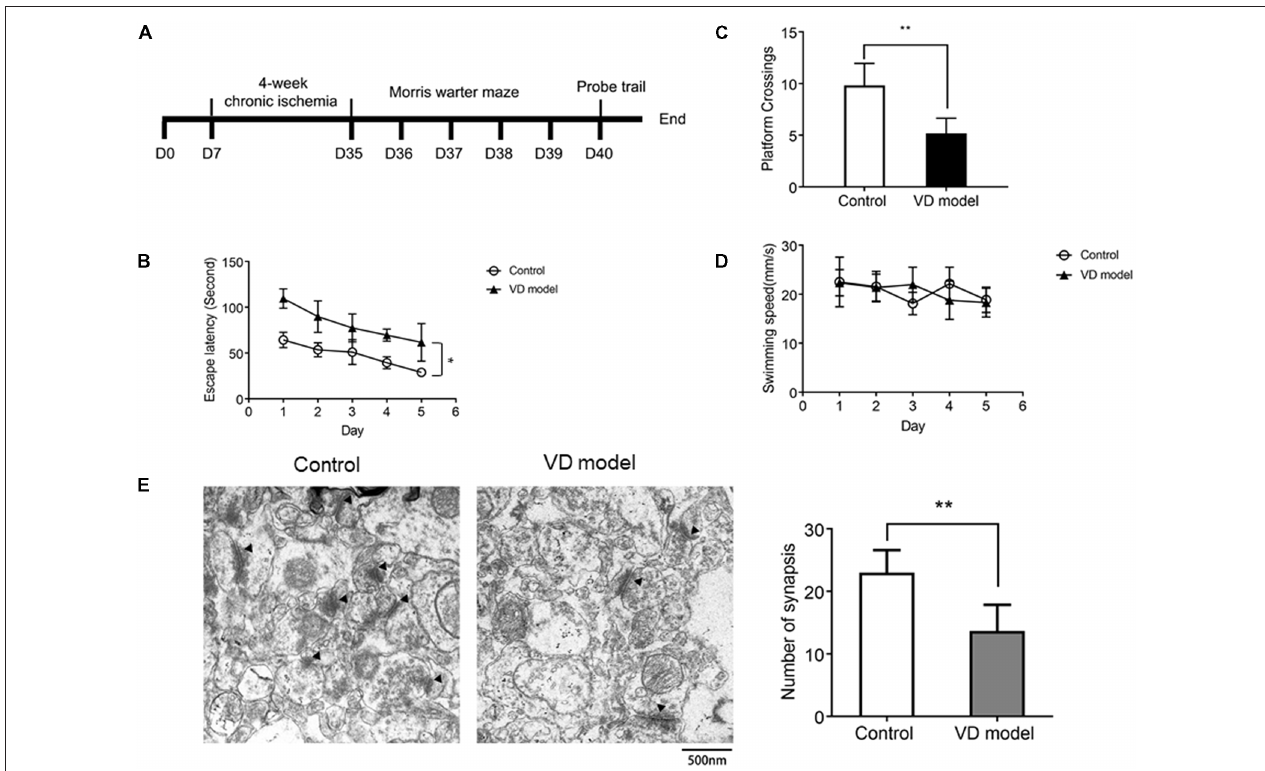
FIGURE 1 | Chronic ischemic rat model exhibits the decline of spatial learning capability ( n = 13/group) and synapse loss in the hippocampus relative to control group ( n = 6/group). (A) The timeline of animal experiment. (B) The escape latency of individual rats was processed by a Morris water maze that lasts for 5 days (four times per day). (C) The number of platform crossings measured within 120 s. (D) The motor function was assessed by the swimming speed. (E) Synapses were indicated with black triangles; bar chart showed the number of synapses. Data are shown as mean ± standard deviation (SD) values, and statistical significance between both groups is defined as ∗ p < 0.05; ∗∗ p <